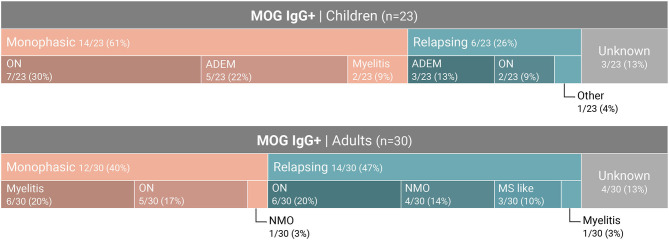
Distribution of seropositive MOG-abs among pediatric and adults clinical phenotype.